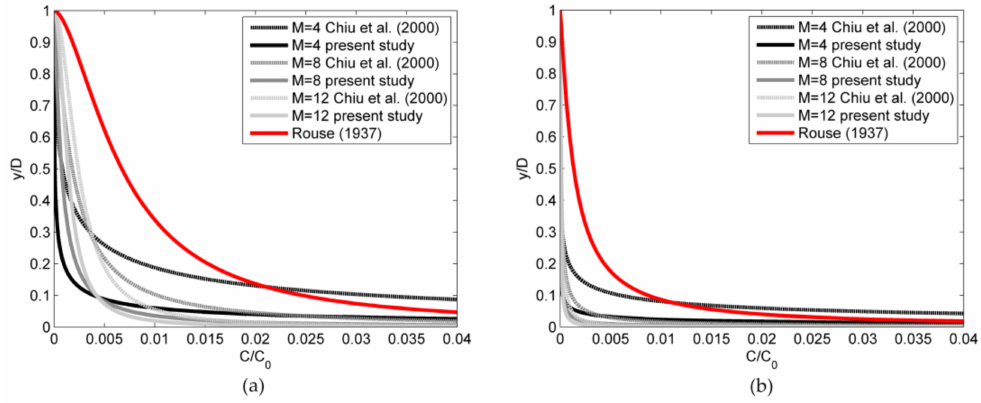
Figure 6. Comparison among the prediction by Equation (6) by Rouse [12], Equation (9) by Chiu et al. [30], Equation (21): ( a ) d =0.105 mm from Coleman’s data set ( λ = 5.6) and ( b ) d = 0.210 mm from Coleman’s data set ( λ = 8.2).